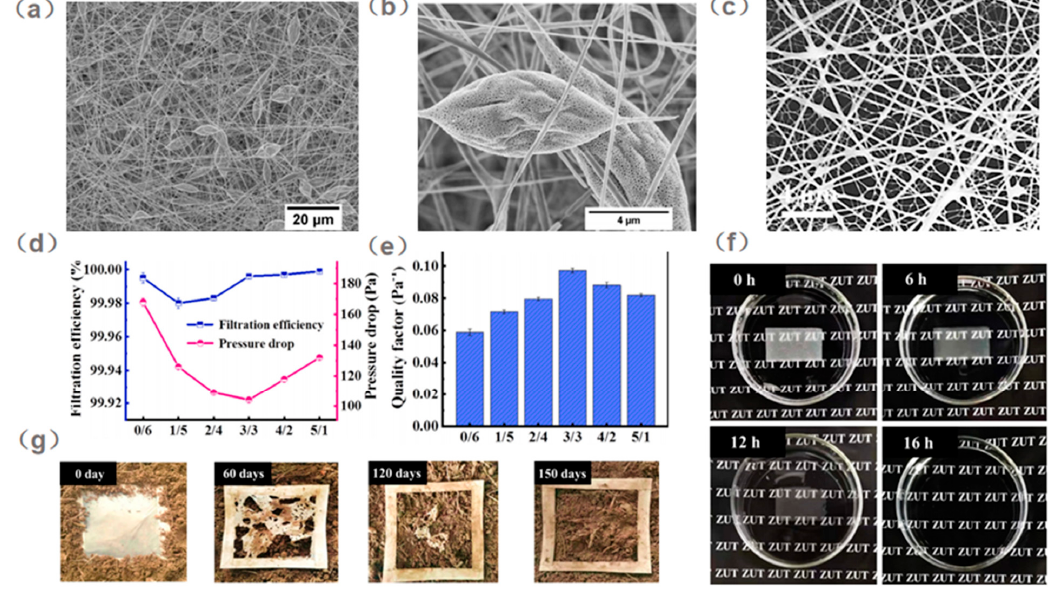
Figure 4. SEM images of ( a ) the porous bead-on-string PLA fibers fabricated from 5 wt% PLA solutions in 10/1 DCM/DMAC by weight, and ( b ) a corresponding highly magnified image, and ( c ) multi-scale structured membranes with the number of spinning unit ratio of 2/4 [92]. ( d ) Filtration performance and ( e ) quality factor of multi-scale structured membranes with the different number of spinning unit ratios of TN − PLA to S − PLA. ( f ) Time-dependent enzymatic degradation images of the MSM − PLA (3/3, 15 mg) and ( g ) Images showing the soil burial degradation of the MSM − PLA (3/3, 40 mg) under natural conditions